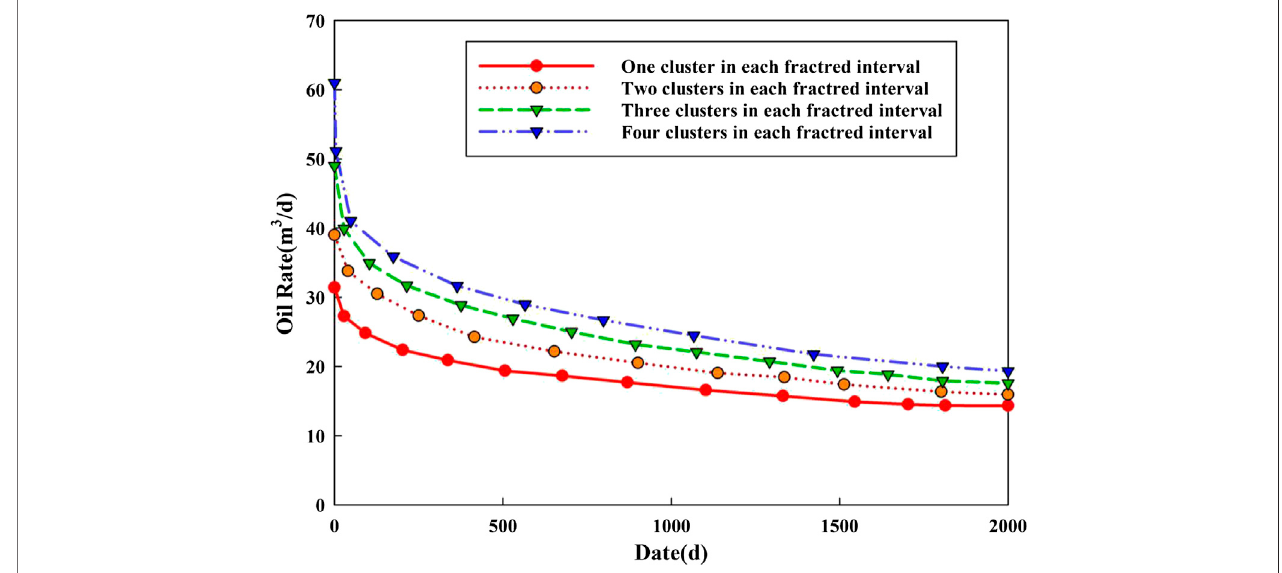
FIGURE 13 | Daily oil production curve of different number of fracture clusters.